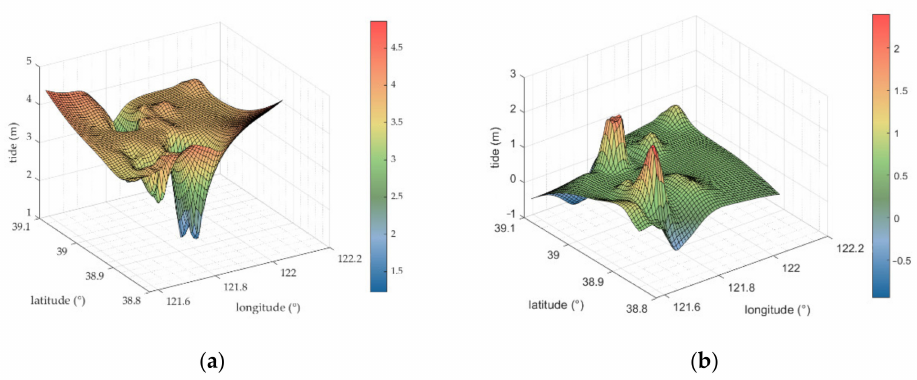
Figure 6. ( a ). The interpolated tide level at high tide. ( b ). The interpolated tide level at low